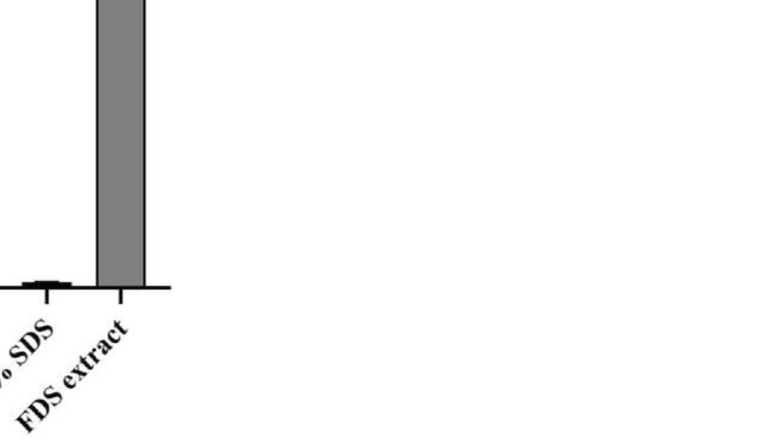
Skin irritation test of the F. dubia sap extract.